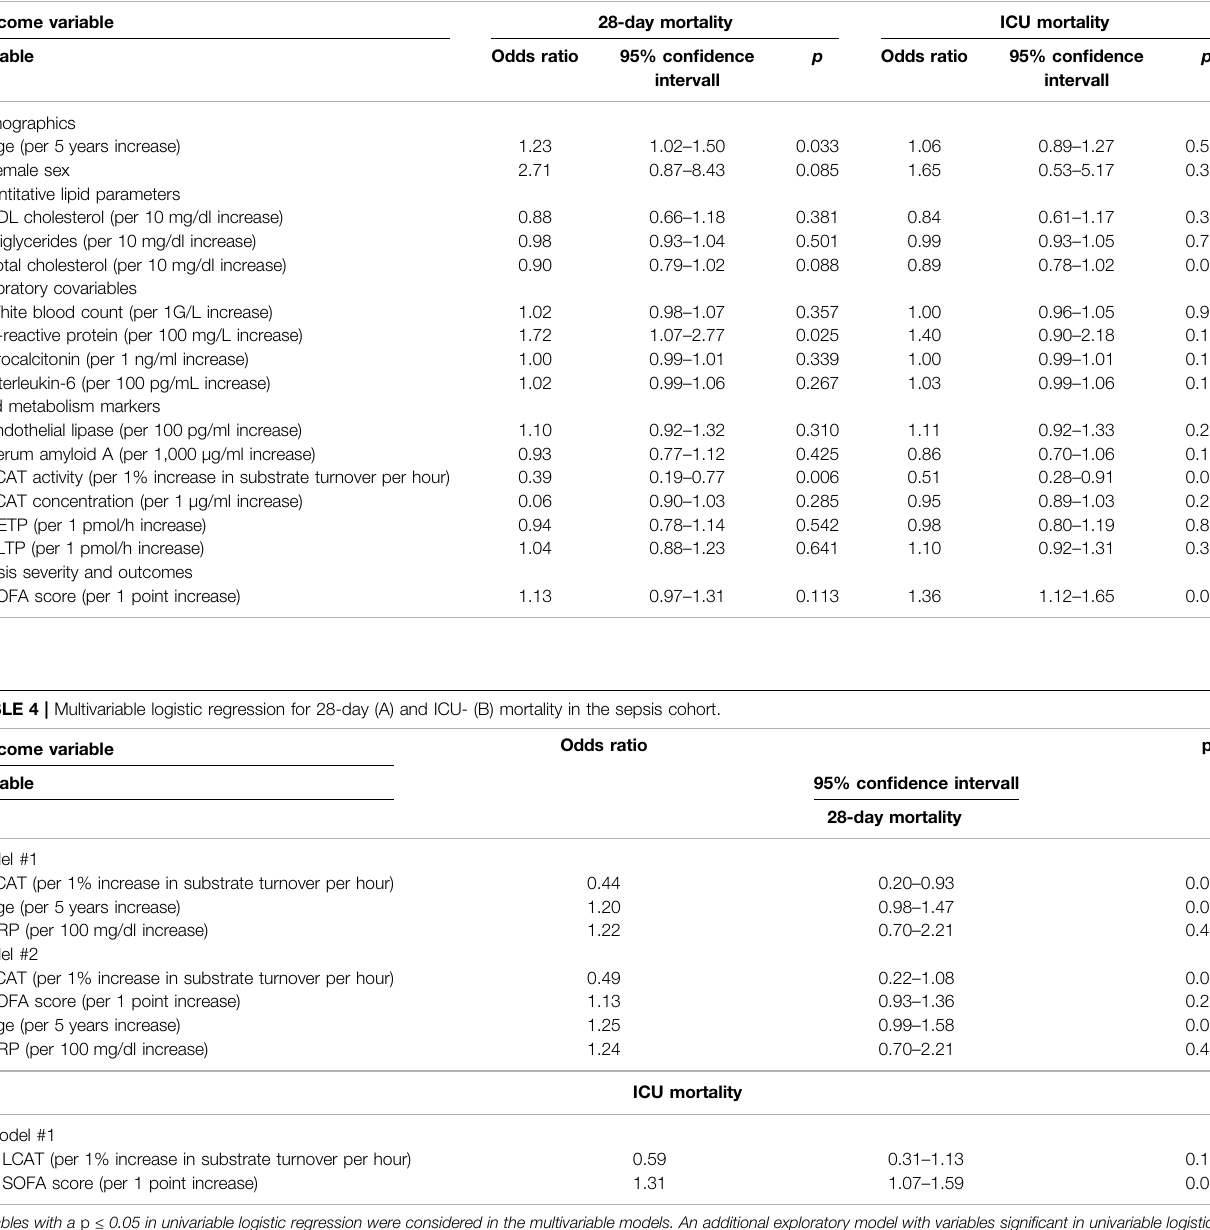
TABLE 3 | Univariable logistic regression for ICU- and 28-day mortality in the sepsis cohort. Abbreviations: HDL, high density lipoprotein; ICU, intensive care unit; SOFA, sequential organ failure assessment; LCAT, lecithin-cholesterol acyltransferase; CETP, cholesteryl ester transfer protein; PLTP, phospholipid transfer protein.